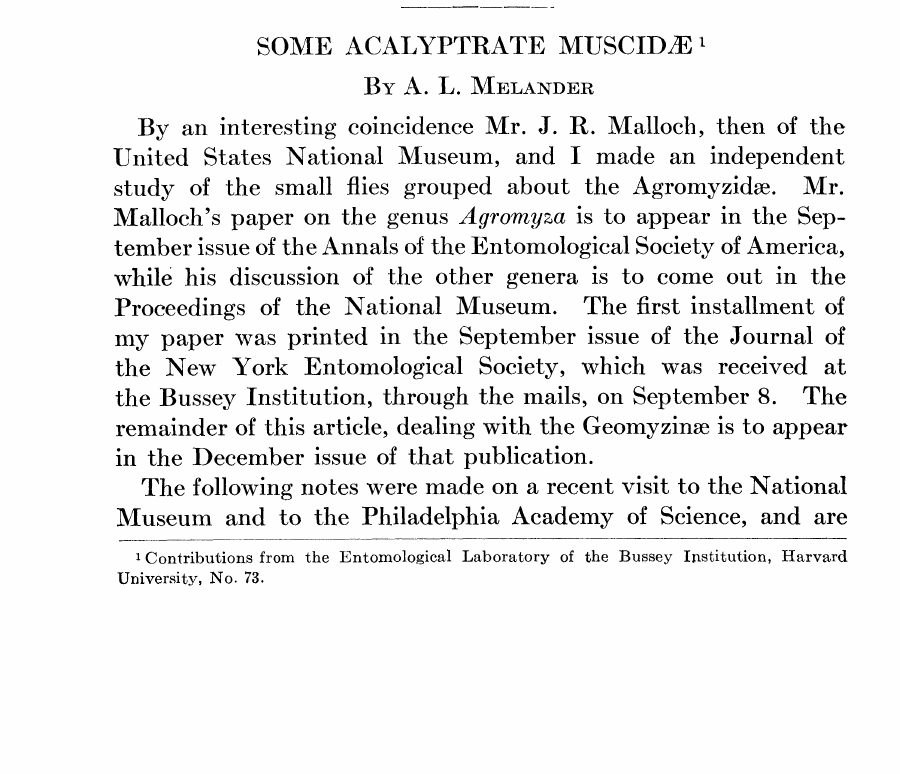
mm. Pale amber yellow in color. At the anterior end are two prominent cephalad projecting set,e; the elongate lanceolate thoracic respiratory organs are yellow. Seven segments may be distinctly seen in the ab-- domen, of which the first four are each provided with a curved pointed appendage, on each side ventrally; across the center of the dorsum of each of the first six abdominal segments is a transverse row of about 38 setulm. The last segment is. provided with four stout diverging spines. Imago. Male and female. Length, 1.75 mm., without the hypopygium. Palpi pale yellow, face and front metallic blue, in some lights with a greenish tinge. An- tennae amber yellow, arista pubescent. Frontal setm and those of thorax and abdo- men pale yellow. Eyes sparsely pubescent, cilia of inferior orbit pale. Mesonotum and abdomen bright metallic green with bluish reflections, the former slightly pruinose, the latter with yellow hairs; scutellum metallic blue; prescutellar depres- sion shallow; pleura metallic green, darker toward the bas of the wings. Tegulm pale yellow with pale hairs. Hypopygium (fig. 6) of the male fuscous, the appen- dages yellow; the basal sclerite which forms the capsule, elongate oval, the lamellse pear-shaped with several conspicuous, pale, setse. Ovipositor of the female fer- ruginous. Legs and coxm pale yellow. Halteres yellowish. Wings hyaline with dusky yellow veins, venation as figured (fig.